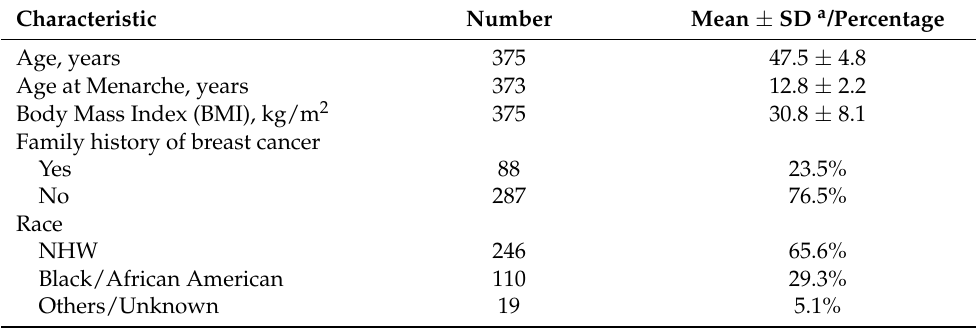
Table 1. Characteristics of 375 premenopausal women recruited during the annual screening